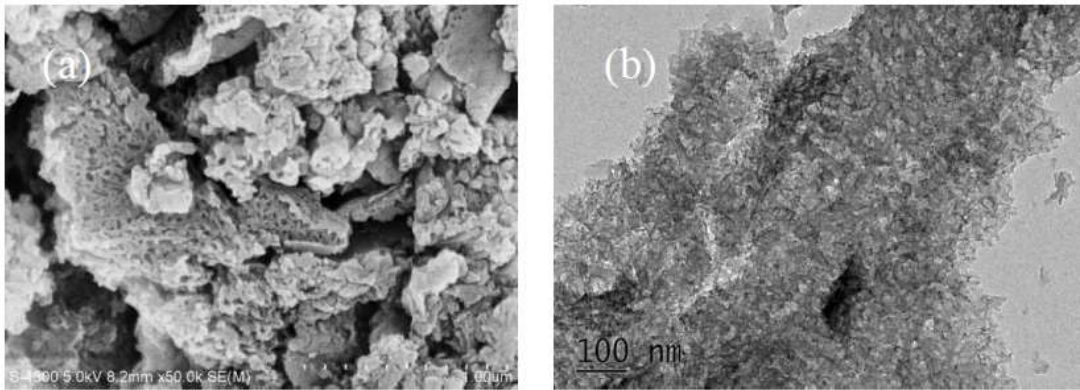
Figure 14. The SEM ( a ) and TEM ( b ) micrographs of B2-CN after the adsorption-photocatalytic process.